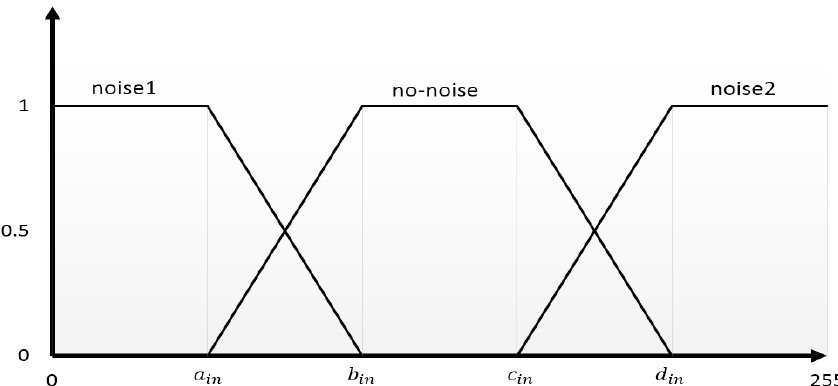
Figure 4. Four input attributions of three membership functions.